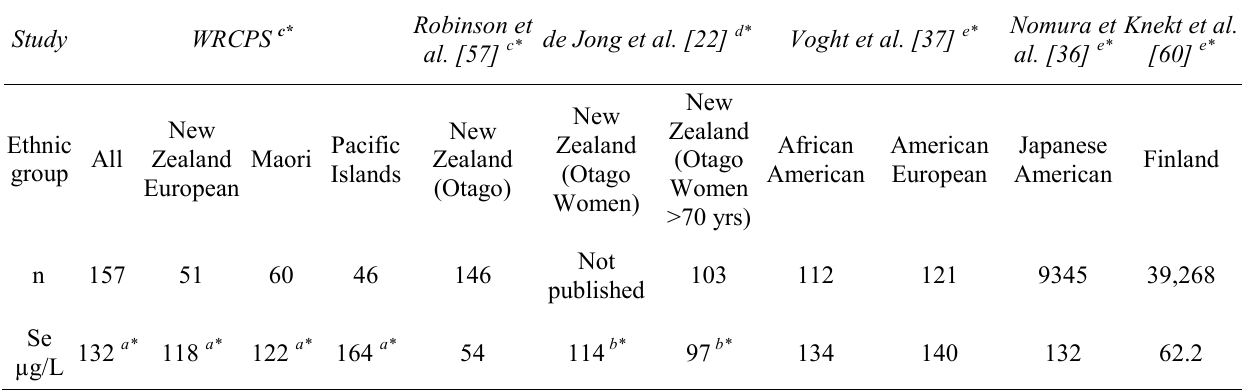
Table 3: Blood Se level by ethnicity of the WRCPS, compared with other community-based studies.